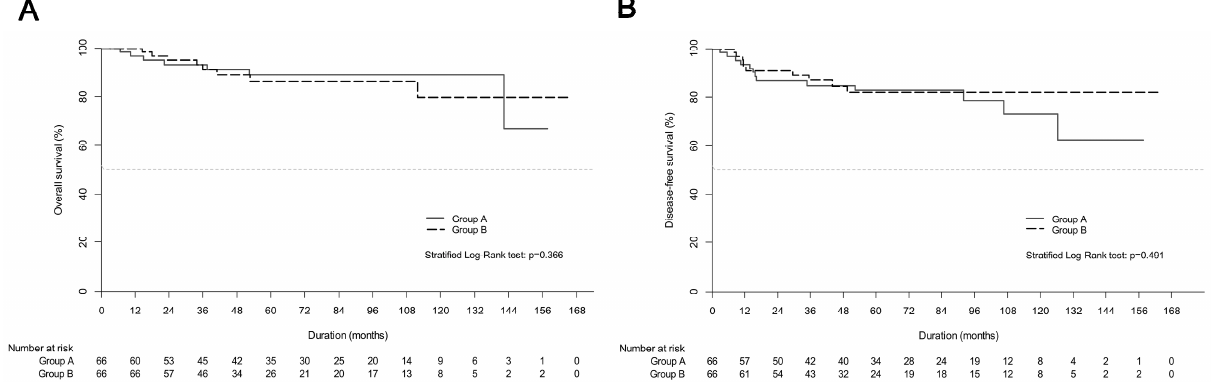
Figure 2. Kaplan-Meier estimates of ( A ) overall survival curves and ( B ) disease-free survival curves between definitive chemoradiotherapy (group A) and upfront radical hysterectomy followed by tailored adjuvant therapy (group B) in propensity score matching cohort.